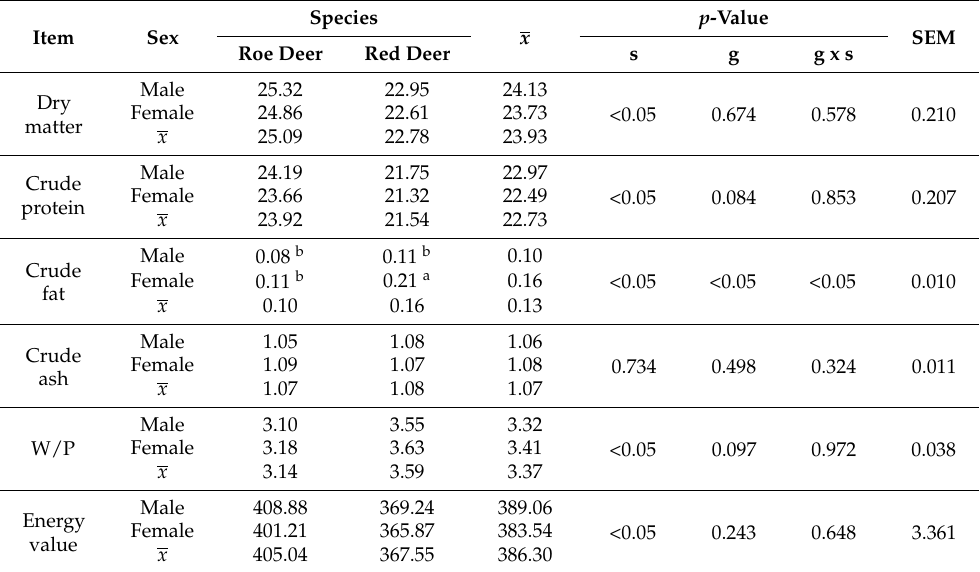
Table 1. Proximate composition (%) and energy value (kJ/100 g) of musculus semimembranosus of roe deer and red